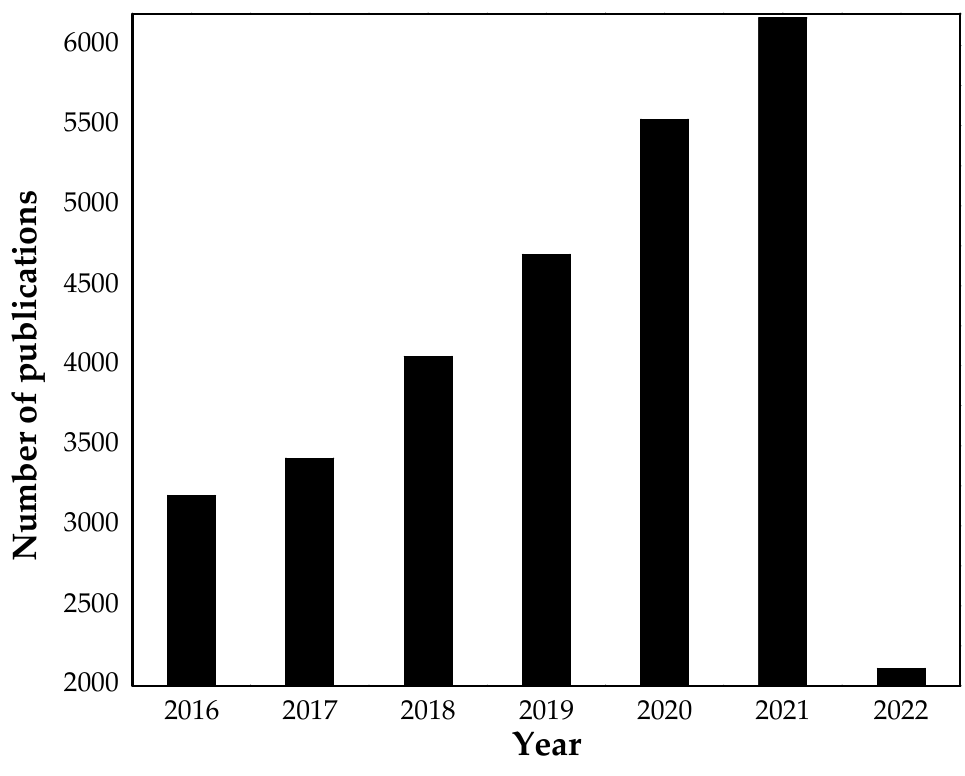
Figure 1. Total number of articles in Scopus about dye removal by liquid–liquid extraction from 2016 to 2022.